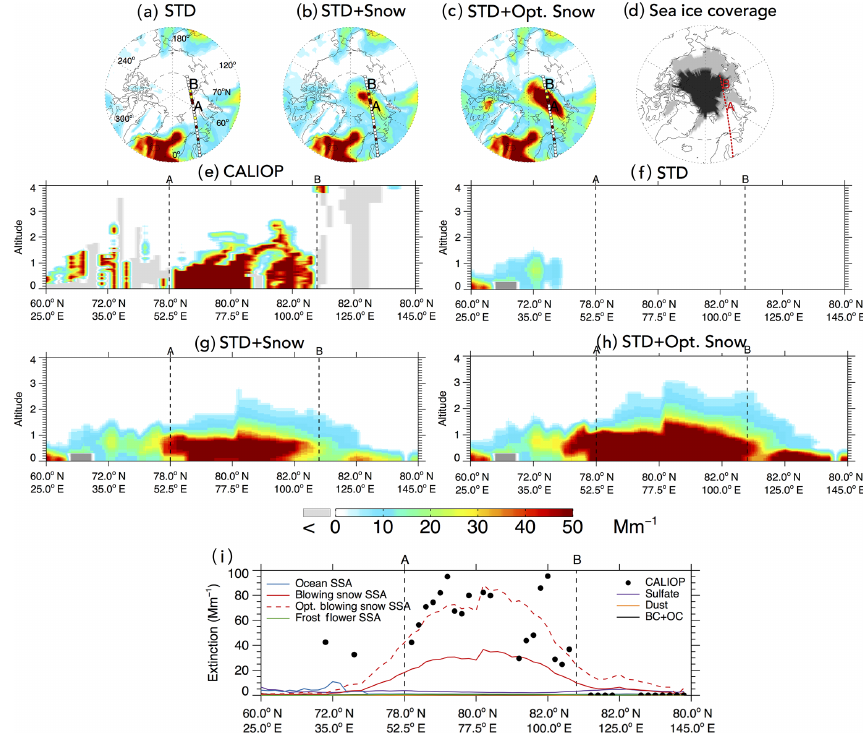
Figure 7. 6 November 2008 case study of a blowing snow SSA feature over the Arctic. Top panels: spatial distribution of mean aerosol extinction below 2km altitude for the (a) STD, (b) STD + Snow, and (c) STD + Opt. Snow GEOS-Chem simulations. The CALIOP nighttime overpass at 00:58–01:12UTC is displayed in the top panels, with filled circles color-coded according to observed mean extinction coefficients below 2km. The overpass intercepts the SSA blowing snow feature between points A and B. Panel (d) shows the MERRA sea ice coverage on 6 November 2008, with light gray shading indicating FYI and black shading for MYI. Panels (e–h) show the observed and simulated vertical cross sections of aerosol extinction coefficients along the CALIOP overpass. The light gray shading in (e) indicates that no valid data are available for CALIOP. The dark gray shading in (f–h) shows the local topography in the model. Panel (i) shows the 0–2km CALIOP mean aerosol extinction and the contributions of different aerosol types in the GEOS-Chem simulations: sulfate aerosol, dust, black carbon and organic carbon (BC + OC), open ocean SSA, blowing snow SSA, optimized blowing snow SSA, and frost flower